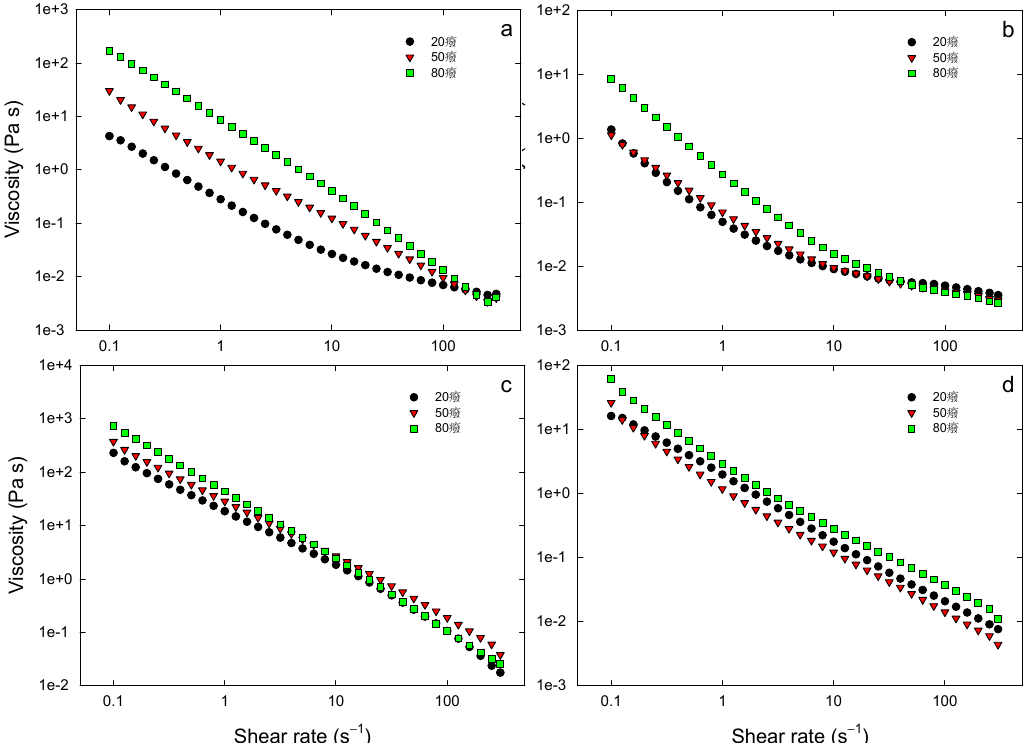
Figure 6. Flow measurements (apparent viscosity as a function of shear rate) in steady-state conditions at different temperatures of freshly prepared emulsion stabilized with BM30-CP ( a ), BM60-CP ( b ), HPH-NC ( c ), or HPH-TP ( d ). Each flow curve is the average of five measurements.